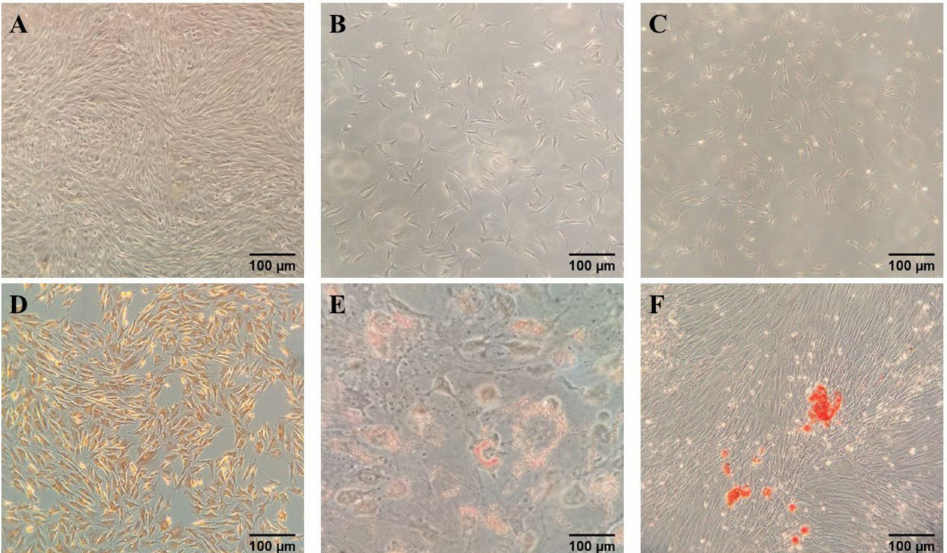
Figure A1. Histological staining of rAT-MSCs. ( A – C )—Non-differenced cells remained unstained; ( D )—deposits of proteoglycan in the differentiation-induced sample are stained with Safranin-O; ( E )—lipid drops are stained red by Oil-Red- O; ( F )—red dye Alizarin-Red-S identifies accumulation of calcium aggregates (Scale bars = 100 µ